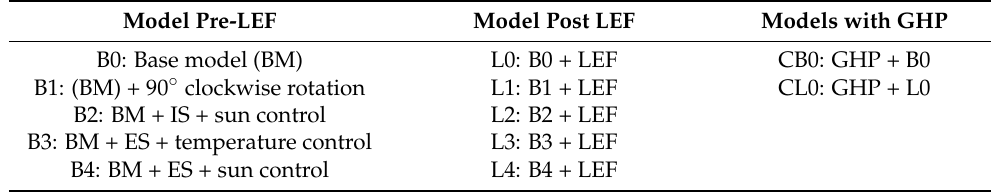
Table 7. Case configuration list for B, L, and C-cases.